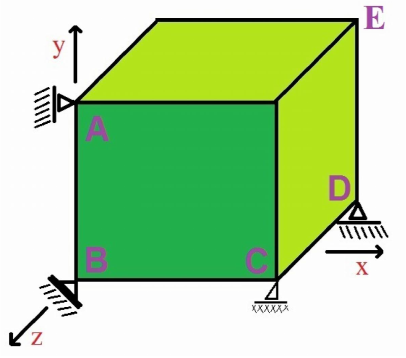
Figure 2. Boundary condition considered.